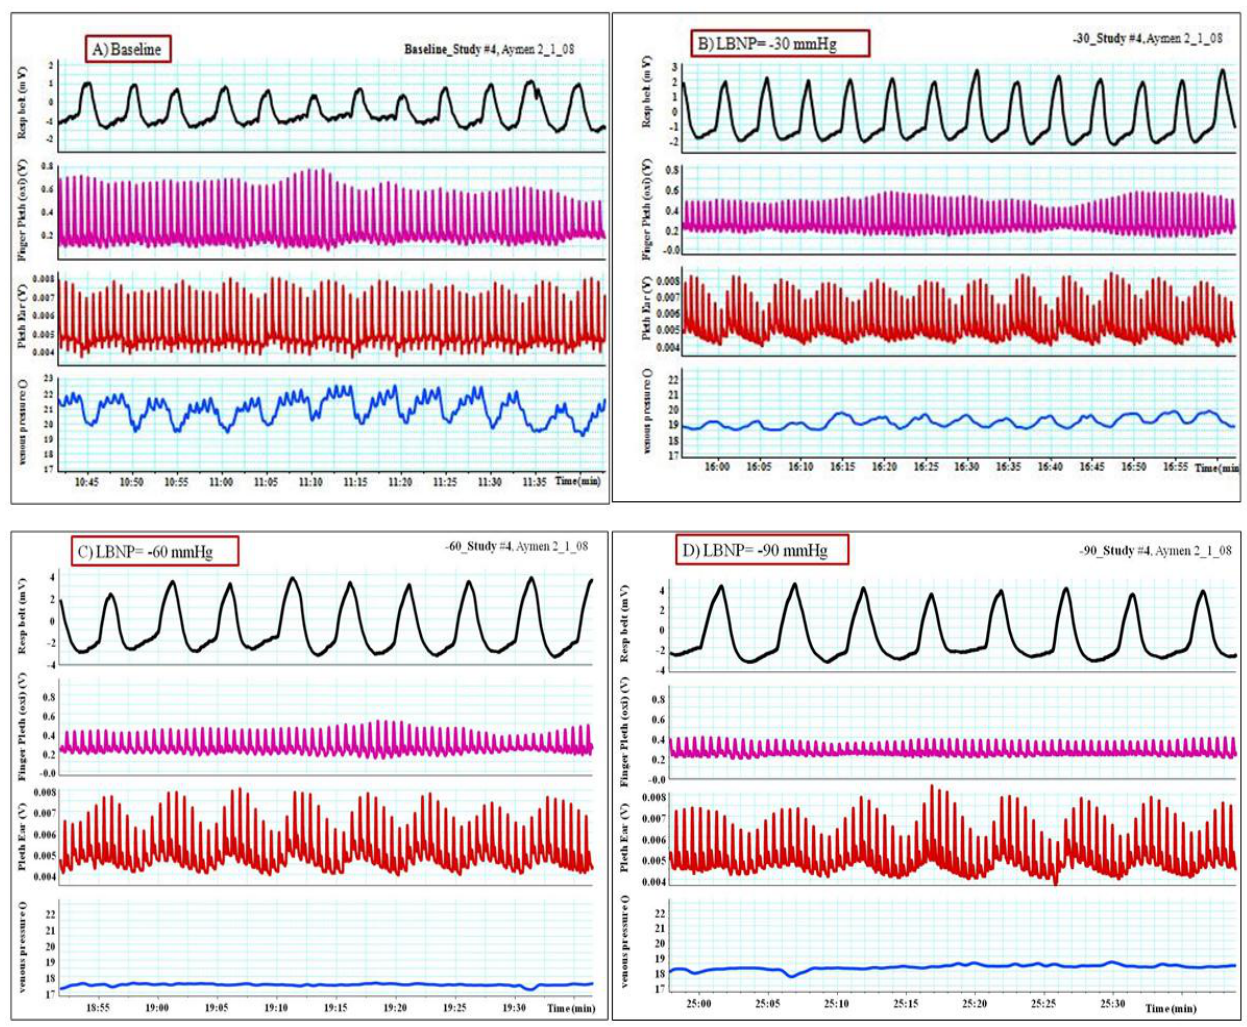
Figure 13. Changes in the plethysmographic waveforms from the ear and the finger together with changes in the peripheral venous pressure in spontaneously breathing patients underwent simulating hypovolemia by application of lower body negative pressure to the lower extremities. ( A ) Baseline, ( B ) LBNP = − 30 mmHg, ( C ) LBNP = − 60 mmHg and ( D ) LBNP = − 90 mmHg. Notice the drop in the PVP and the marked vasoconstriction of finger PPG while the ear PPG showing an increase in the modulation with the progress of LBNP